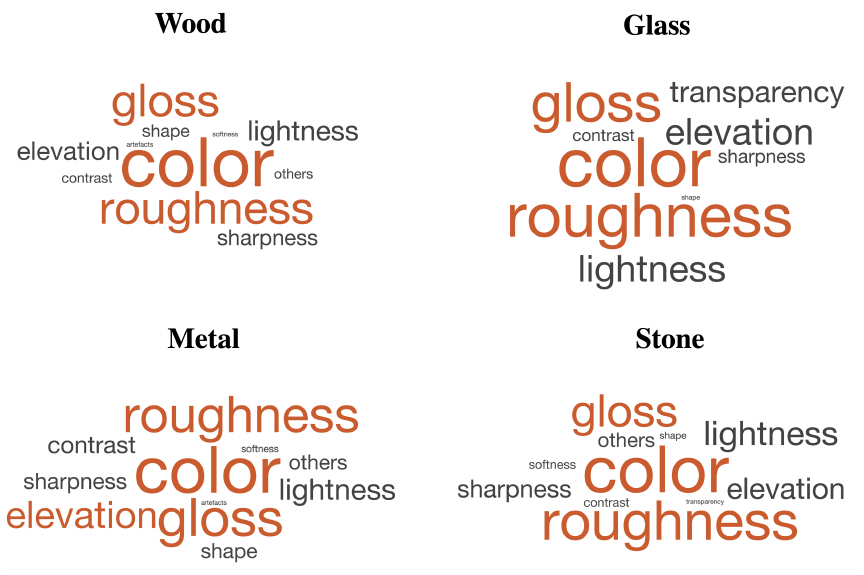
Figure 6. The most used level 1 perceptual attributes for wood, glass, metal, and stone material categories. The size of the attribute’s text is the frequency of its